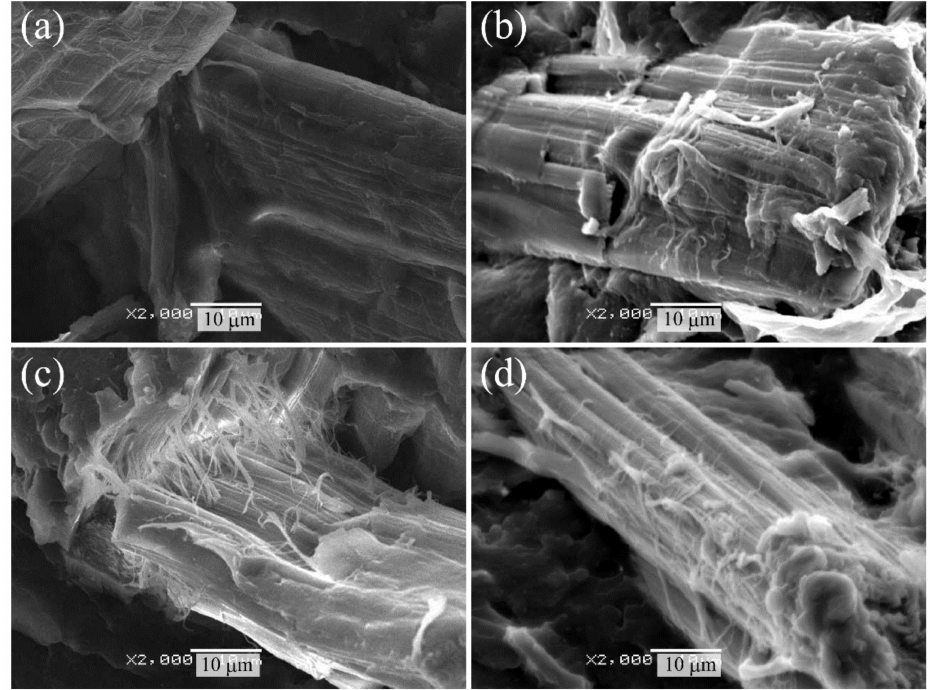
Figure 2. Scanning electron microscope (SEM) photographs of the cryogenically fractured surface of various surface-treated hemp-fiber-reinforced plant-derived polyamide 1010 (HF/PA1010) biomass composites: ( a ) HF_NaClO 2 , ( b ) HF_NaClO 2 + EP, ( c ) HF_NaClO 2 + A-1160, and ( d ) HF_NaClO 2 + A-1160 + EP ( ×